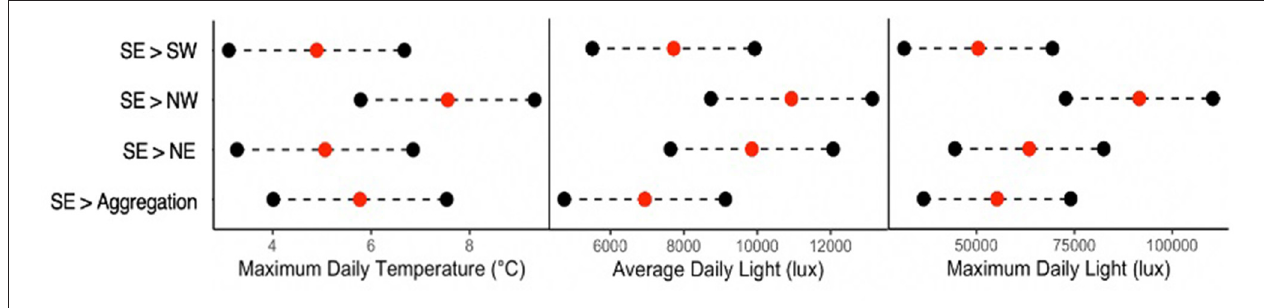
FIGURE 4 | Magnitude and direction of significant pairwise differences ( Table 1 ) across all the five locations in the groves are shown on the ordinate (the location of the pair with the greatest absolute value is shown by the “ < ” symbol. Tests account for blocking among the groves and temporal autocorrelation of the data. All significant pairwise differences were between SE and the four other locations, and for maximum daily temperature, average daily light, and maximum daily